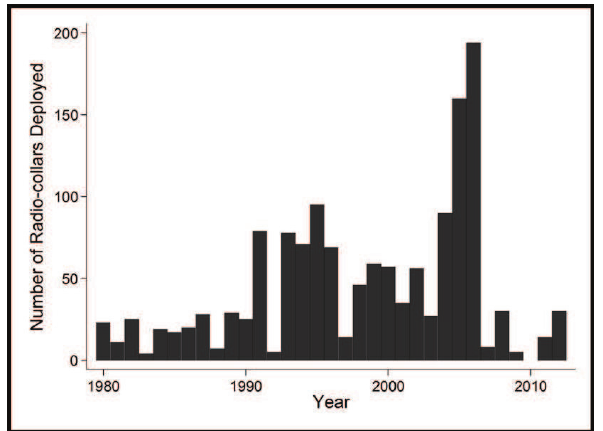
Fig. 2. Number of radio-collars deployed on Yukon north- ern mountain caribou from 1980 – 2012.